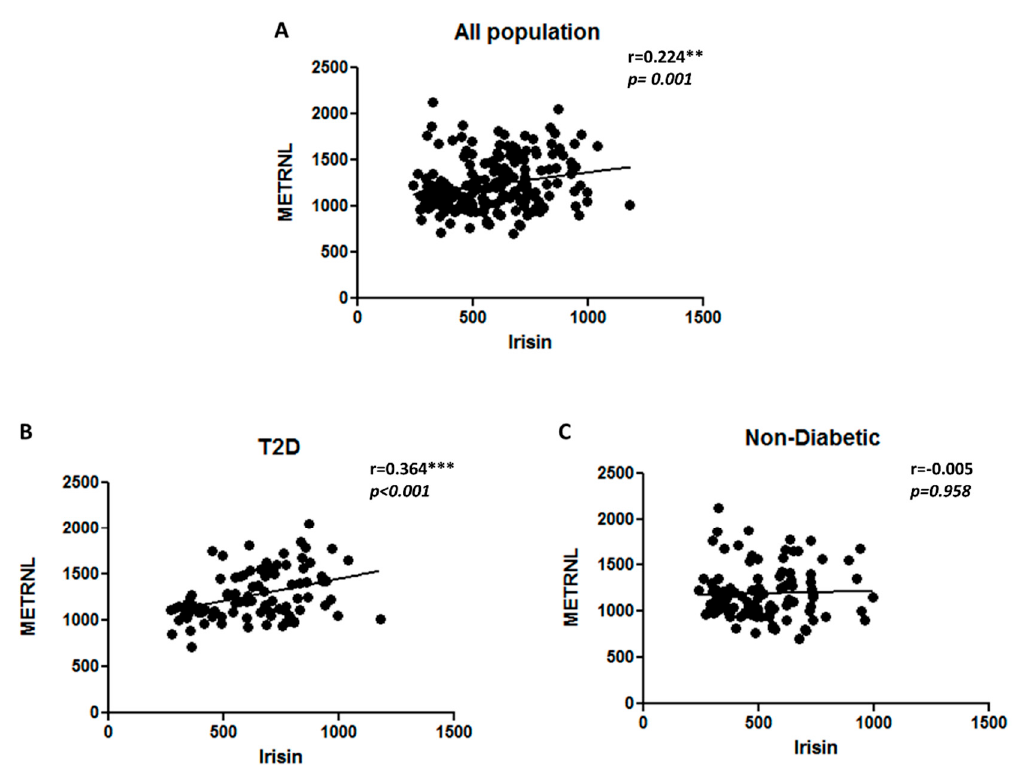
Figure 5. Correlation analysis between METRNL and irisin levels in plasma. ( A ) All populations. ( B ) Individuals with T2D. ( C ) Non-diabetic individuals. METRNL and irisin levels in plasma were determined using enzyme linked immunosorbent assay. Diabetes was defined by fasting plasma glucose ≥ 126 mg/L (7 mmol/L). Spearman correlation coefficient was used to determine the association of METRNL with irisin. Statistical assessment was 2-sided and considered statistically significant at ** p < 0.01; *** p < 0.001.